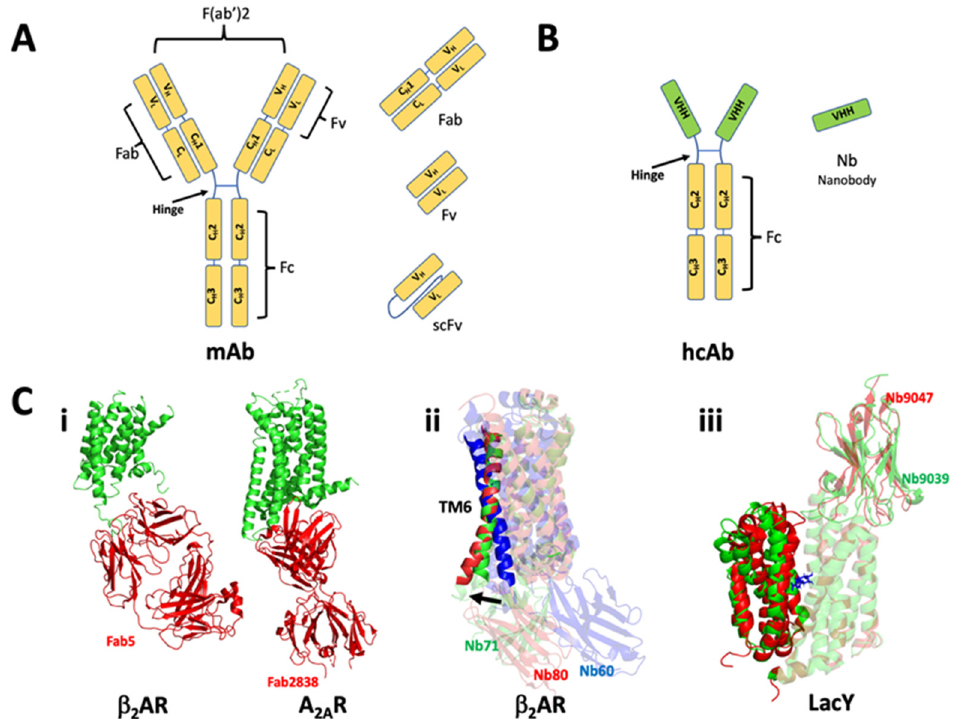
Figure 7. ( A ) Conventional monoclonal antibody (mAb). Various fragments obtain from chemical or enzymatic cleavage. ( B ) Heavy chain antibody (hcAb) found in camelids. The small (~15 kDa) variable region (V HH ) from hcAb is called a nanobody. ( C ) (i) Ab fragment stabilized conformers. Structure of β 2 AR and A 2A R stabilized by antibody fragments Fab5 (PDB 2R4R) and Fab2838 (PDB 3VG9). (ii) Alignment of β 2 AR structures in the presence of different conformational Nbs 60 (5JQH), 71 (6MXT), 80 (3P0G), mimicking a transition from inactive to active state, indicated the outward movement of intracellular TM6. (iii) Overlay of outward-open structures of LacY in the apo and substrate NPG (blue) bound state, conformationally trapped by Nb 9039 (5GXB) and 9047 (6C9W)